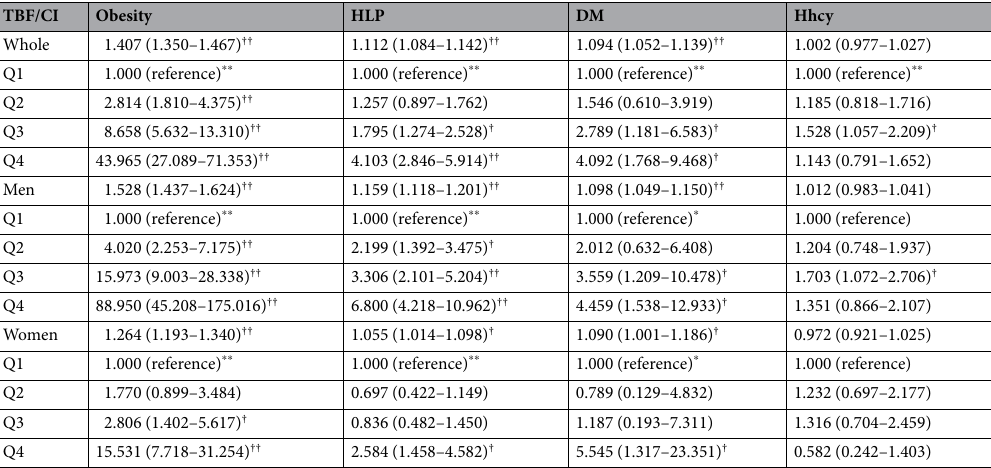
Table 2. The odds of TBF/CI in metabolic diseases. Abbreviations: TBF/CI: total body fat/conicity index; HLP: hyperlipidemia; DM: diabetes mellitus; Hhcy: hyperhomocysteinemia. TBF/CI: Quartile1: < 11.44 kg 3/2 /m 3/2 , Quartile2: 11.44–14.51 kg 3/2 /m 3/2 , Quartile3: 14.51–17.87 kg 3/2 /m 3/2 , Quartile4: > 17.87 kg 3/2 /m 3/2 . Each of